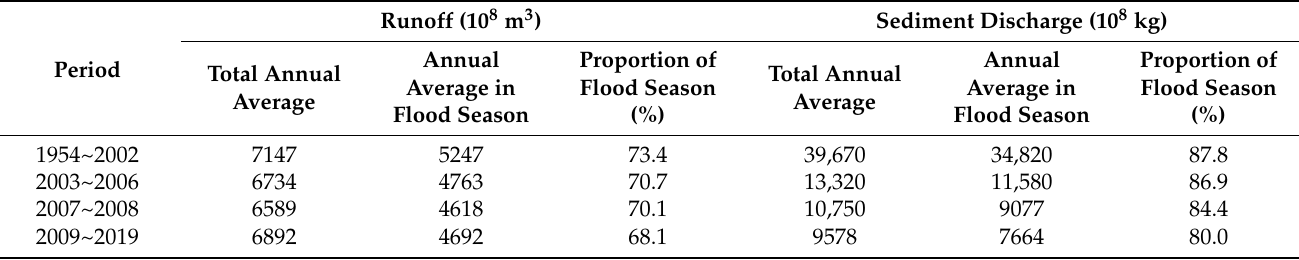
Table 3. Statistics of the flow and sediment discharges of previous years at Hankou Hydrological Station.